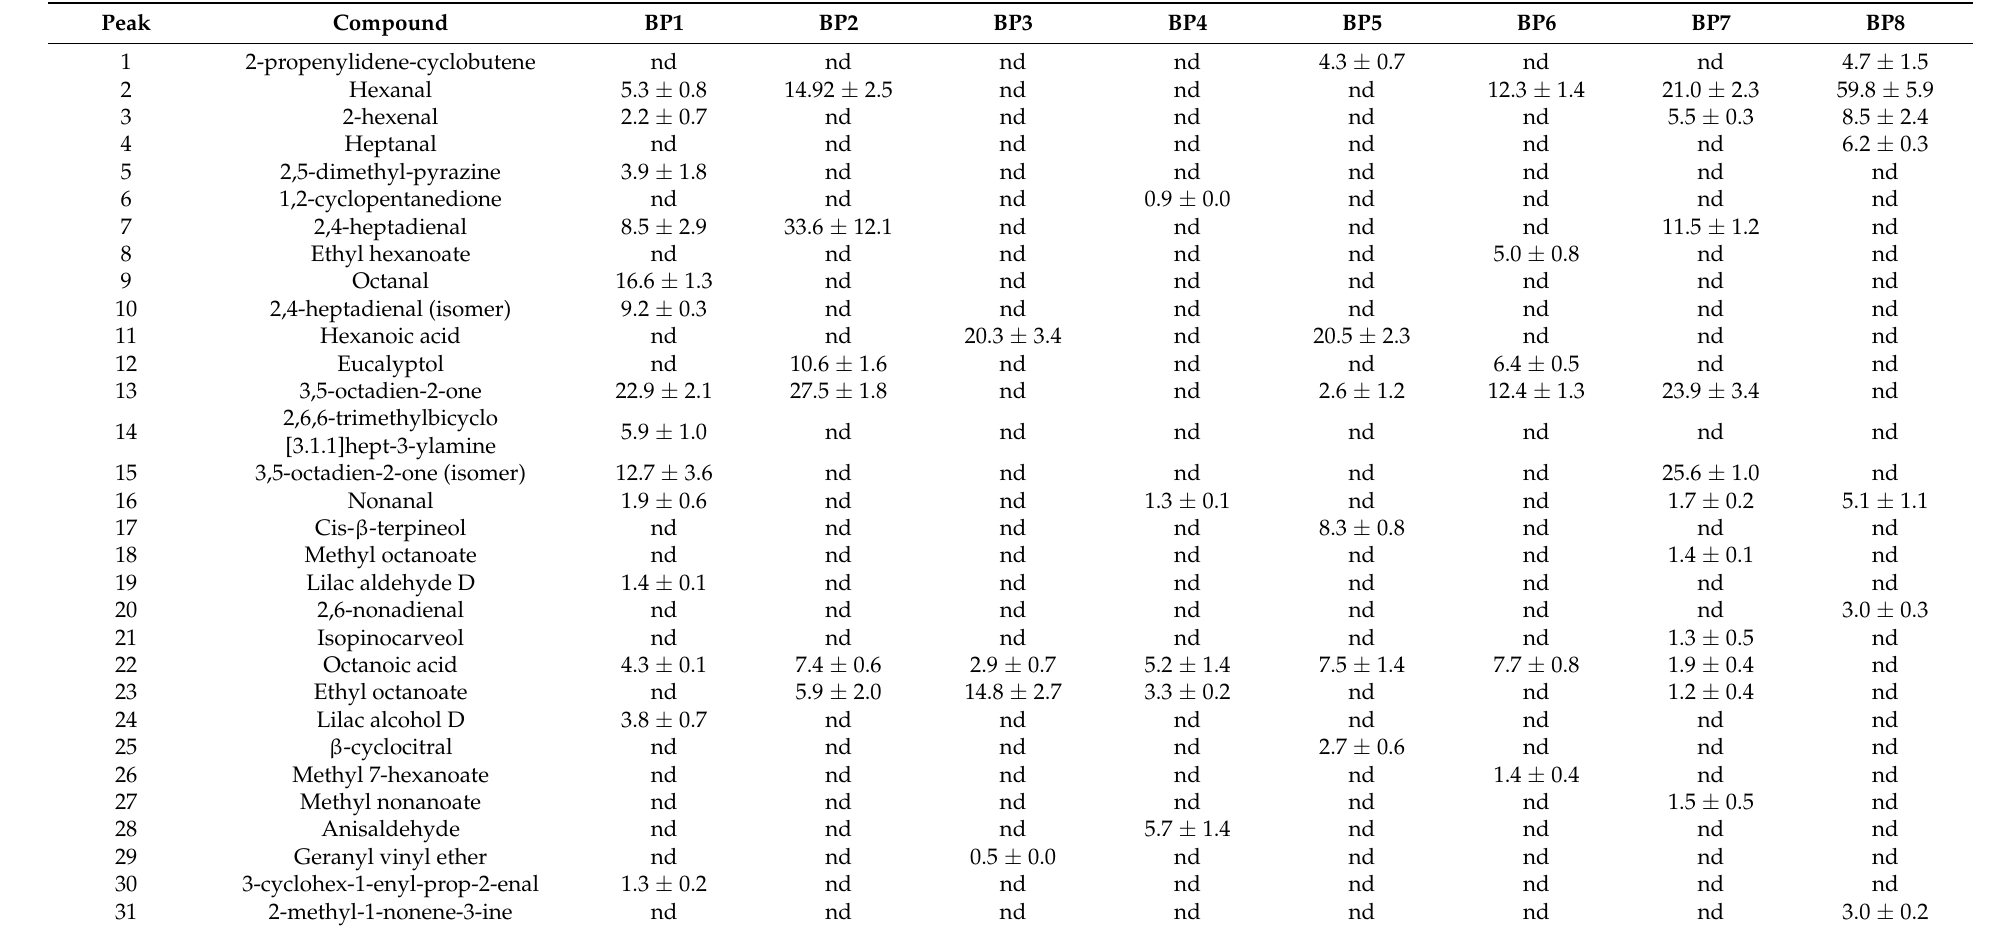
Table 3. Identification and quantification of volatile compounds in Moroccan bee pollen samples. The values are expressed as the relative percentage (R%).